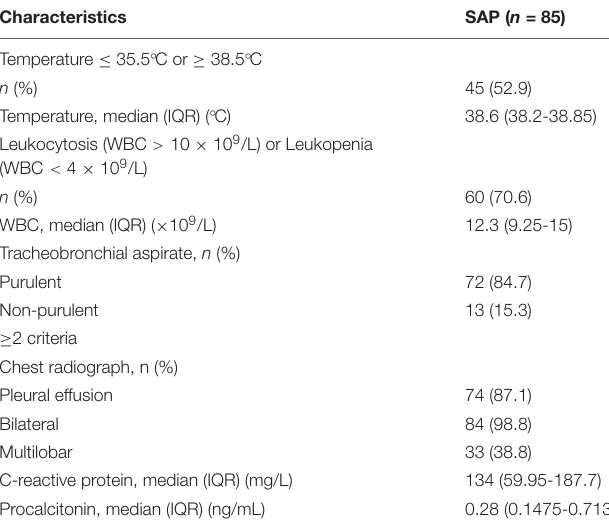
TABLE 2 | Clinical characteristics of the patients with microbiologically confirmed SAP. Characteristics